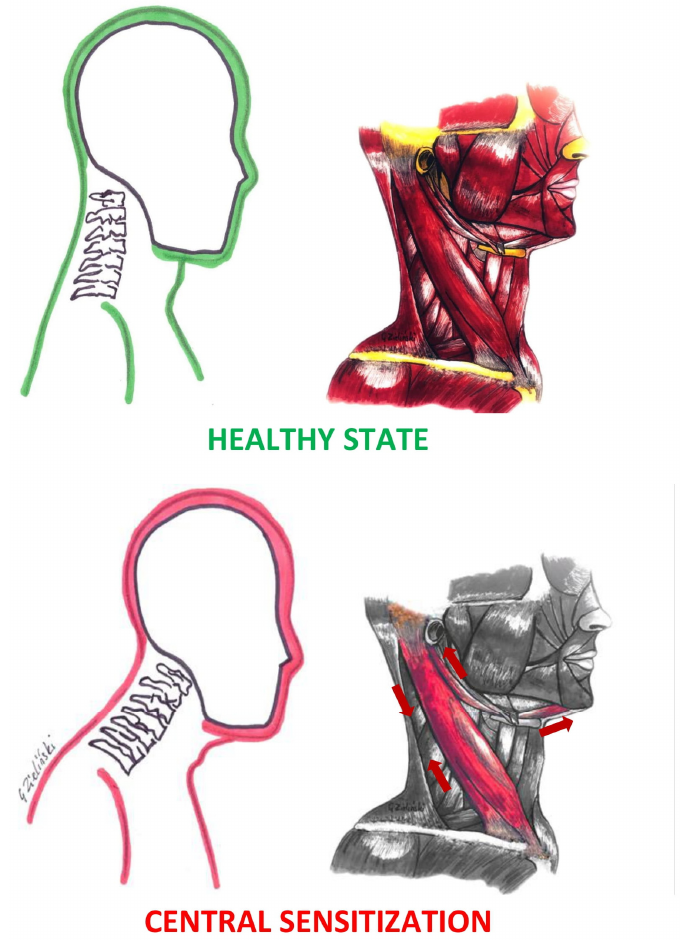
Figure 4. Hypothetical presentation of changes in muscle activity with increasing central sensitization inventory score.